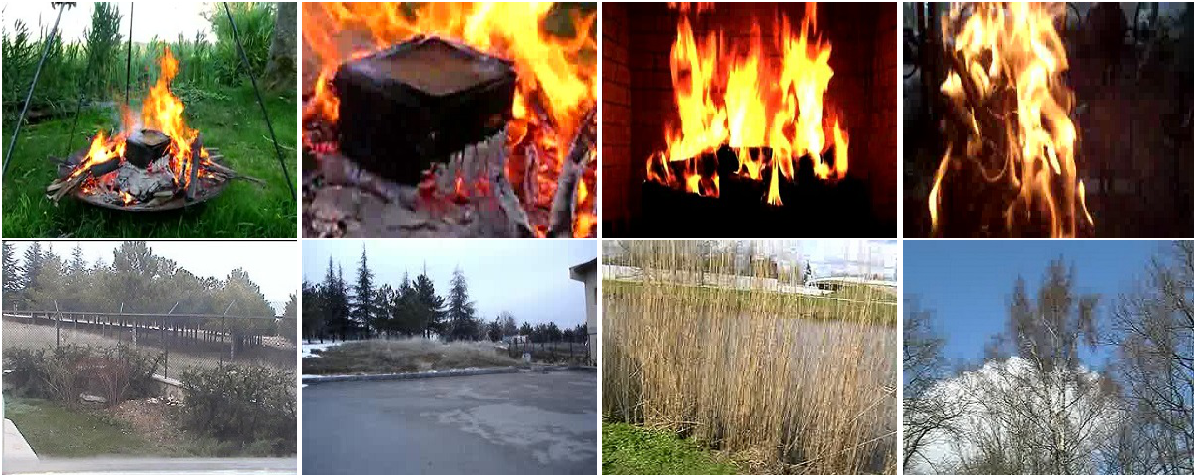
Figure 12. Examples from the Firesense dataset. ( Top ): Fire images; ( Bottom ): non-fire images.